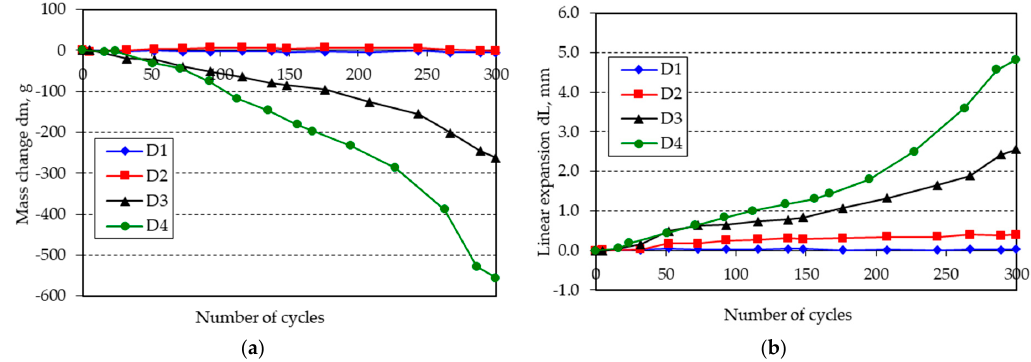
Figure 4. ( a ) Mass change; ( b ) linear expansion of specimens D1–D4 following freezing and thawing in water.